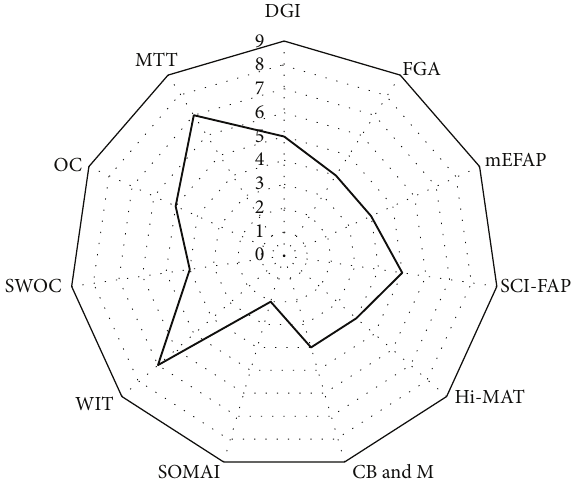
Figure 3: Number of walking adaptability domains captured by clinical assessments of walking function. The number of domains captured by clinical assessments range from 2 to 7, with the SOMAI capturing the least number of domains and the MTT and WTT capturing the most number of domains. Abbreviations: DGI— dynamic gait index; FGA—functional gait assessment; mEFAP— modified Emory functional ambulation profile; SCI-FAP—spinal cord injury functional ambulation profile; Hi-MAT—high-level mobility assessment test; CB&M—community balance and mobility scale; SOMAI—sensory-oriented mobility assessment instrument; WIT—walking InCHIANTI toolkit; SWOC—standardized walk- ing obstacle course developed by Rubenstein and colleagues [31]; Obstacle course—obstacle course developed by Means [32]; MTT— multiple task